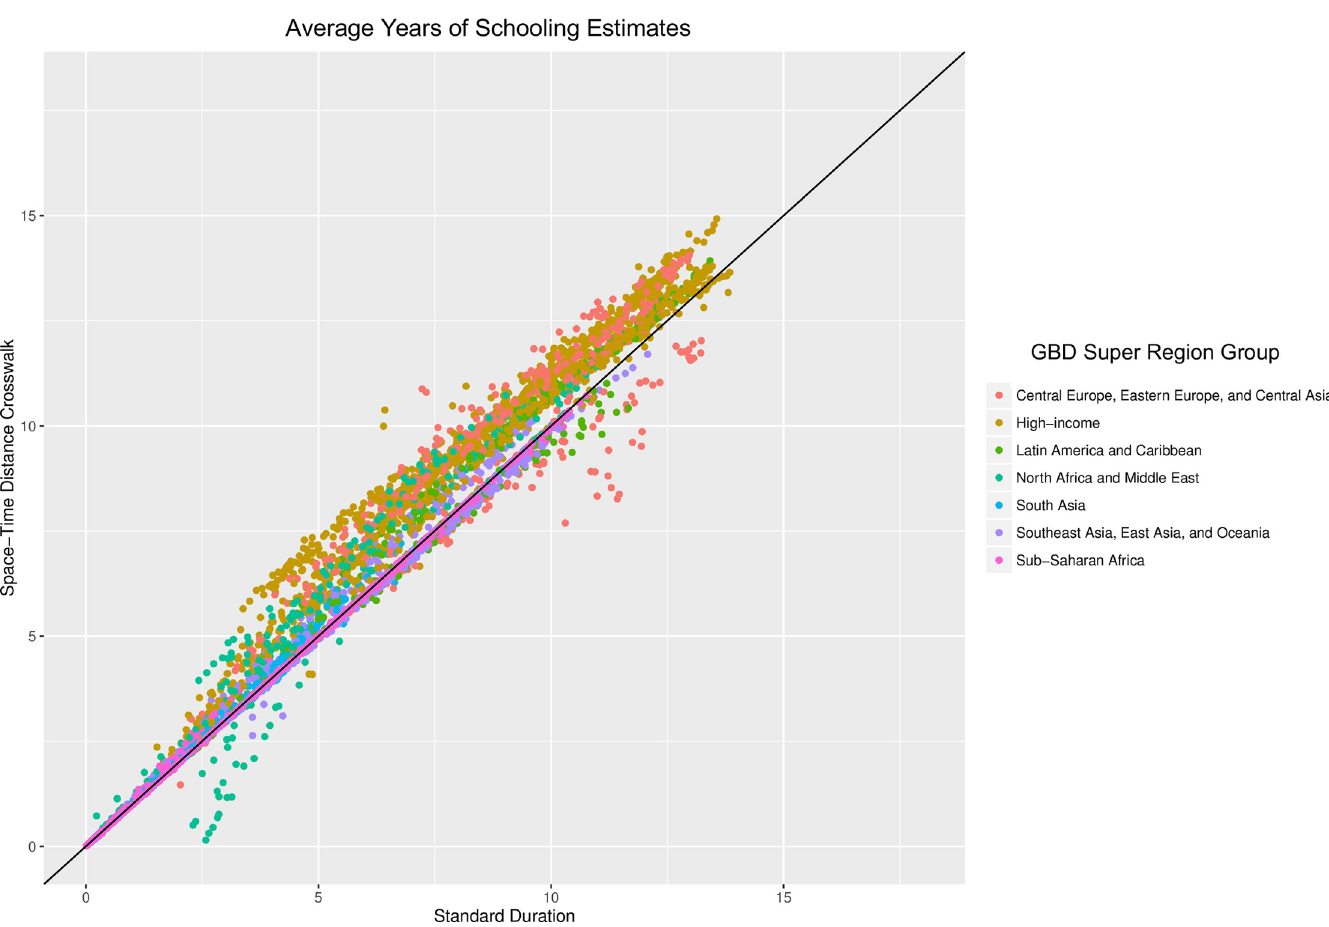
Fig 4. Impact of method choice on average years of schooling estimates. Average years of schooling estimated using the standard duration method (X axis), and the space-time distance model (Y axis) using best performing hyper-parameters. A line of equality added to show the point at which the two models produce identical estimates. Each point is a country-year-sex and five-year age group. Overall the predictions from the standard duration model are lower, with substantial differences between super-region grouping used in the GBD 2015 study, suggesting differential bias.